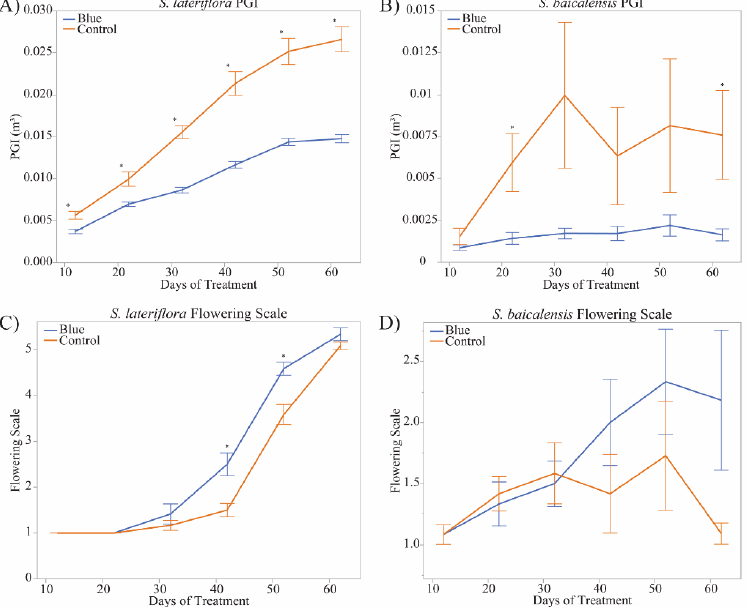
Figure 3. Blue light quality impacts plant growth and flowering. ( A , B ) Plant growth indices (PGI) of S. lateriflora ( A ), and S. baicalensis ( B ). ( C , D ) Flower scale ratings of S. lateriflora ( C ), and S. baicalensis ( D ). Relative flowering on a scale of 1–5 (1 = No flowering; 2 = A few flower buds present; 3 = A few flowers open; 4 = mostly open flowers; 5 = almost all open flowers (peak)). Data presented as means ( S. lateriflora n = 12, S. baicalensis n = 11) ± standard error of the mean. Means with * are significantly different (Student’s t test, p ≤ 0.05).